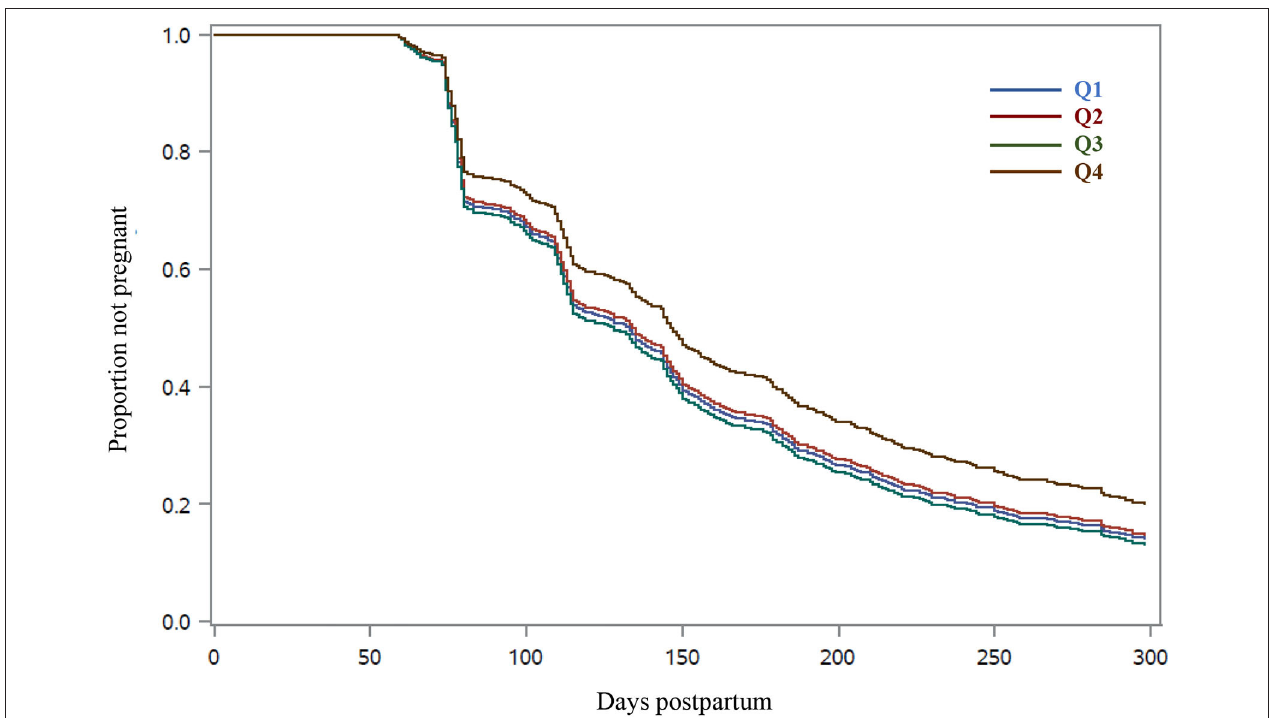
FIGURE 2 | Survival curves for time to pregnancy in Holstein cows according to quartile of residual DM intake (RFI). Residual DM intake was calculated from 1 to 105 days postpartum based on the difference between observed and predicted DM intake, and cows were grouped into quartiles (Q1, smallest RFI, to Q4, largest RFI). Predicted DM intake was calculated following a statistical model that considered NEL secreted as milk, metabolic BW, body energy change, parity group, and treatment nested within the experiment. Cows from quartile 4 had extended time to pregnancy ( P < 0.05) compared with cows from quartiles 1, 2, or 3. The adjusted hazard ratios for the daily rate of pregnancy were greater for Q1 (1.29; 95% CI = 1.03–1.62), Q2 (1.25; 95% CI = 1.00–1.57), and Q3 (1.32; 95% CI = 1.05–1.65) than cows in